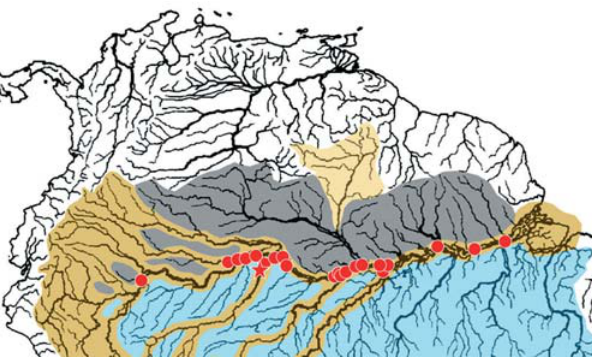
Fig. 27. Distribution of Leptodoras juruensis (star denotes type